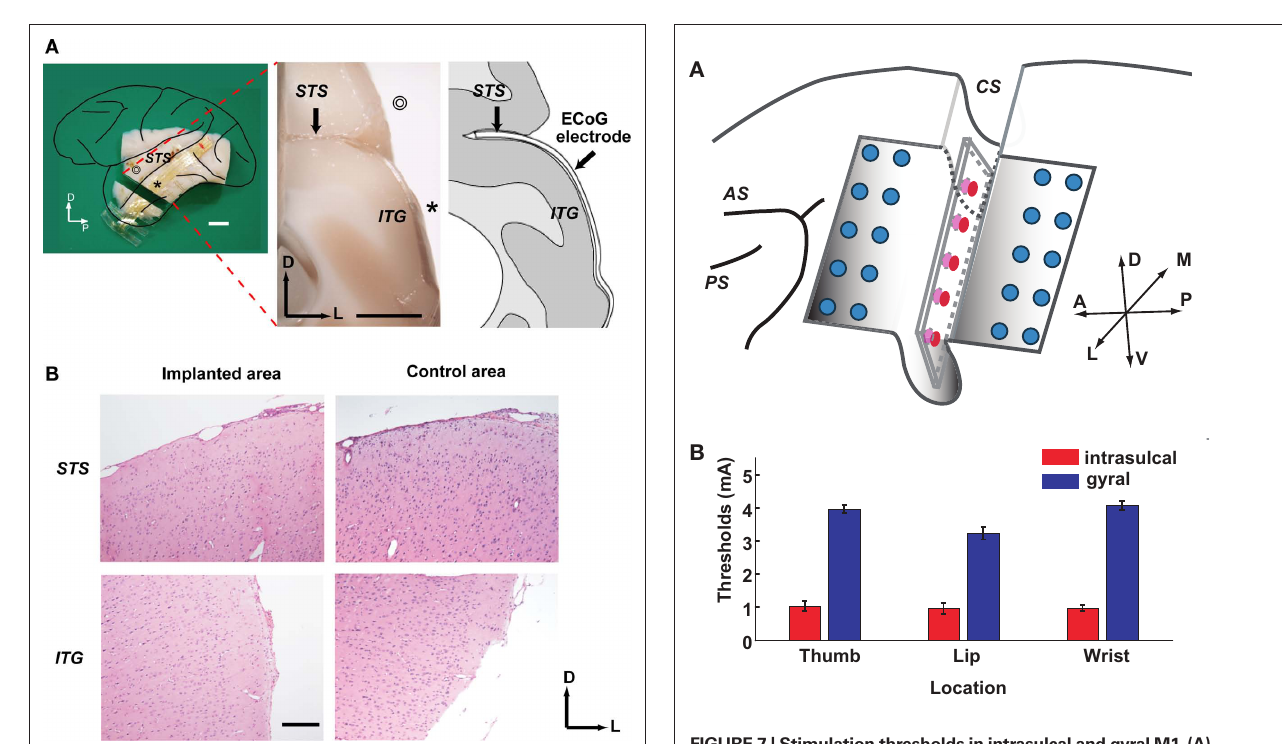
FigurE 7 | Stimulation thresholds in intrasulcal and gyral M1. (A) Schema of the left frontal lobe with the electrode array. Ten-channel array electrodes (red, five channels in one side) placed between banks of CS were used for intrasulcal cortical stimulation. Ten-channel array electrodes of 20-channel probe (blue) covering precentral gyrus were used for the surface cortical stimulation; AS , arcuate sulcus; PS , principal sulcus; CS , central sulcus. (B) Stimulation thresholds of the intrasulcal (red) and gyral (blue) electrodes for motor responses. Bars show the